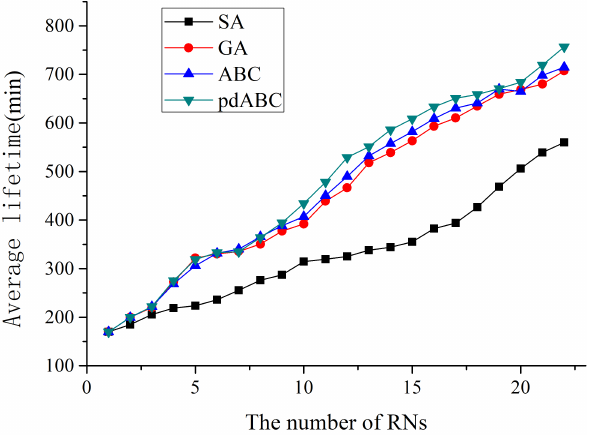
Figure 8. WSN lifetime optimization with different number of RNs in 200 × 200 terrain.